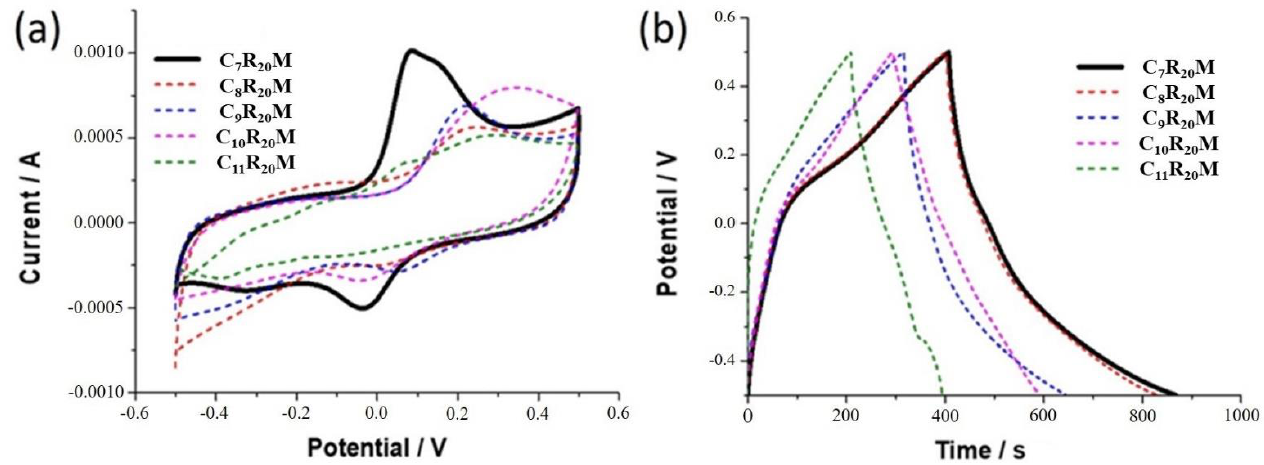
Figure 4. ( a ) CV curves of C x R 20 Melectrodes with various Cu contents, at a scan rate of 10 mV·s −1 , and ( b ) GCD curves of C x R 20 M electrodes with various Cu contents, at a current density of 1 A·g −1 . Table 2. The specific capacitances R s and R ct of the C x R 20 M electrodes evaluated by CV curves, GCD curves and Nyquist plots, with various contents of Cu.